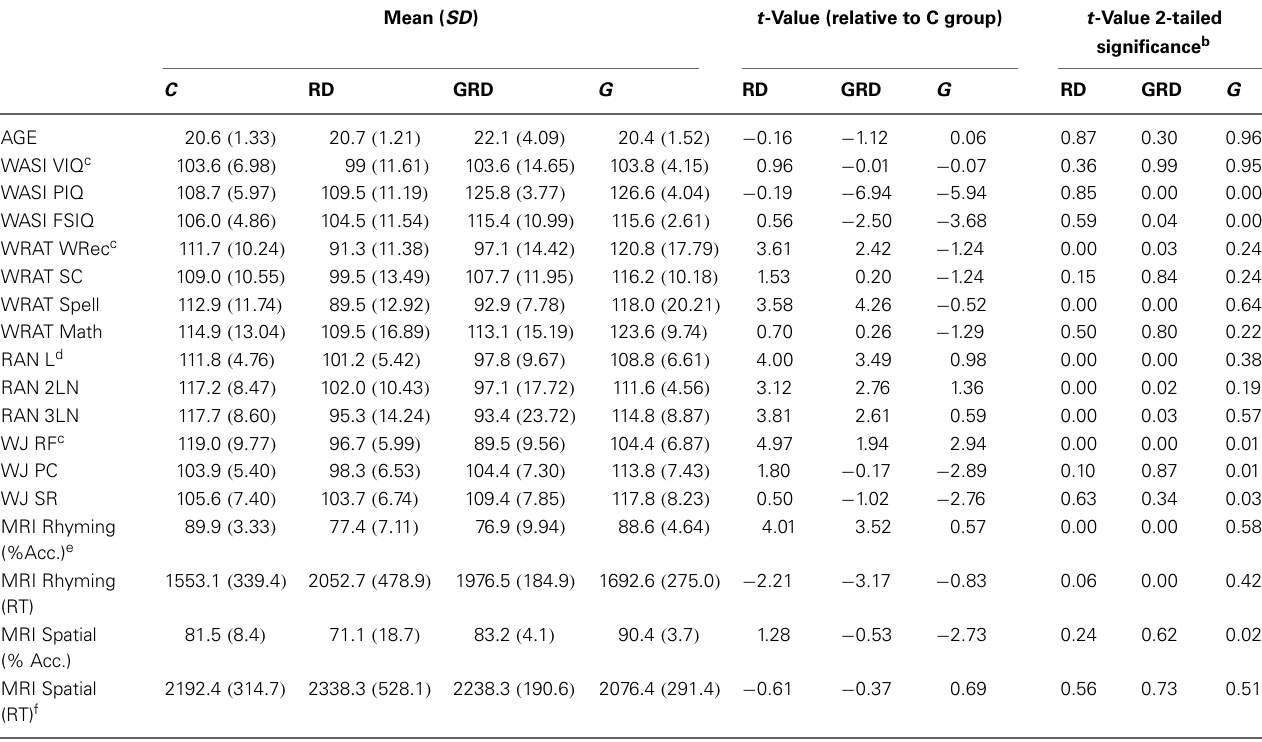
Table 1 | Descriptive data for controls (C), Reading disabled (RD), Gifted (G), and Gifted-reading disabled (GRD) subjects a